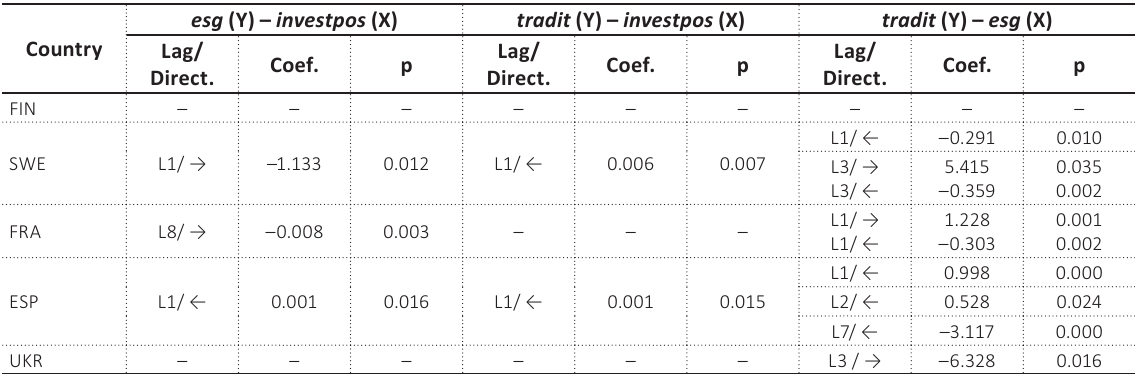
Table 13. VAR analysis results